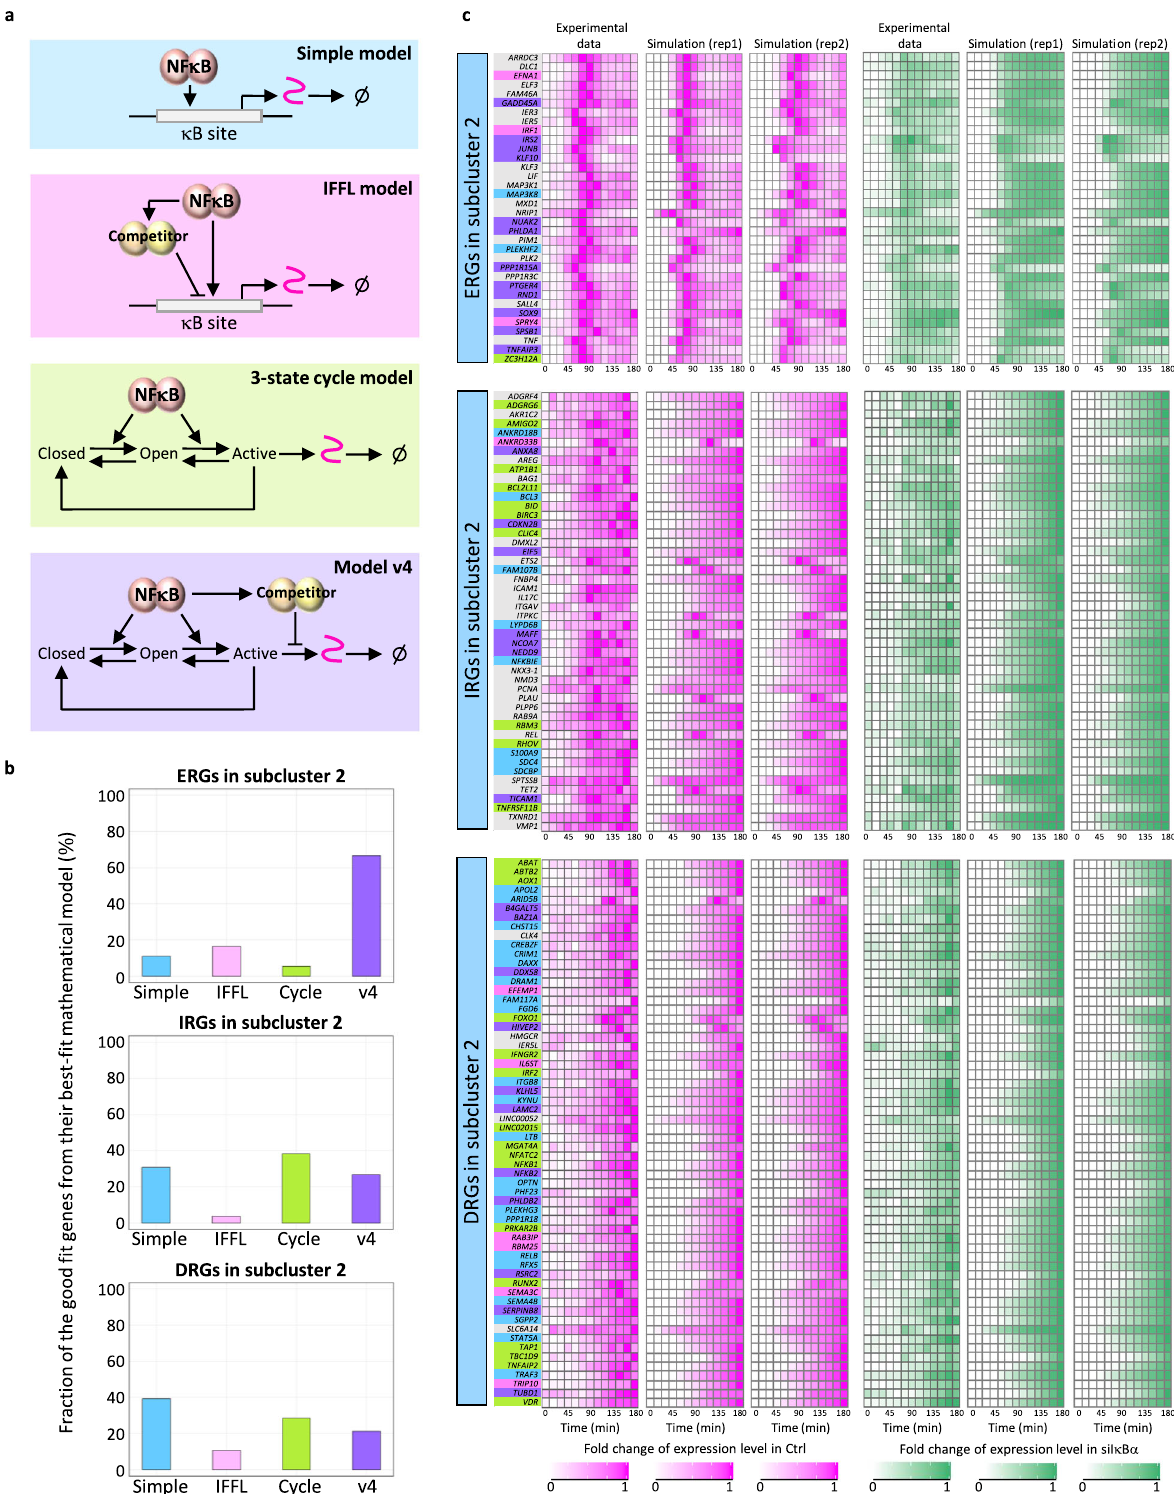
Fig. 3 Model v4 recapitulated fold change in expression of many early response genes in subcluster 2. a Schematic of the four mathematical models. The color code corresponds with the background color of each model. b Fraction of the good- fi t genes from their best- fi t mathematical models. c Heatmaps of the time-course gene expression from experimental results and data fi t from the best- fi t model. Each color bar indicates the best- fi t model (blue: simple model, magenta: IFFL model, green: 3-state cycle model, and purple: model v4), which shows the smallest total nRMSD (nRMSD in Ctrl from rep1 + nRMSD in siI κ B α from rep1 + nRMSD in Ctrl from rep2 + nRMSD in siI κ B α from rep2). Gray colored bars indicate genes that did not show a good fi t with any of the four mathematical models, and the results from the simple model are